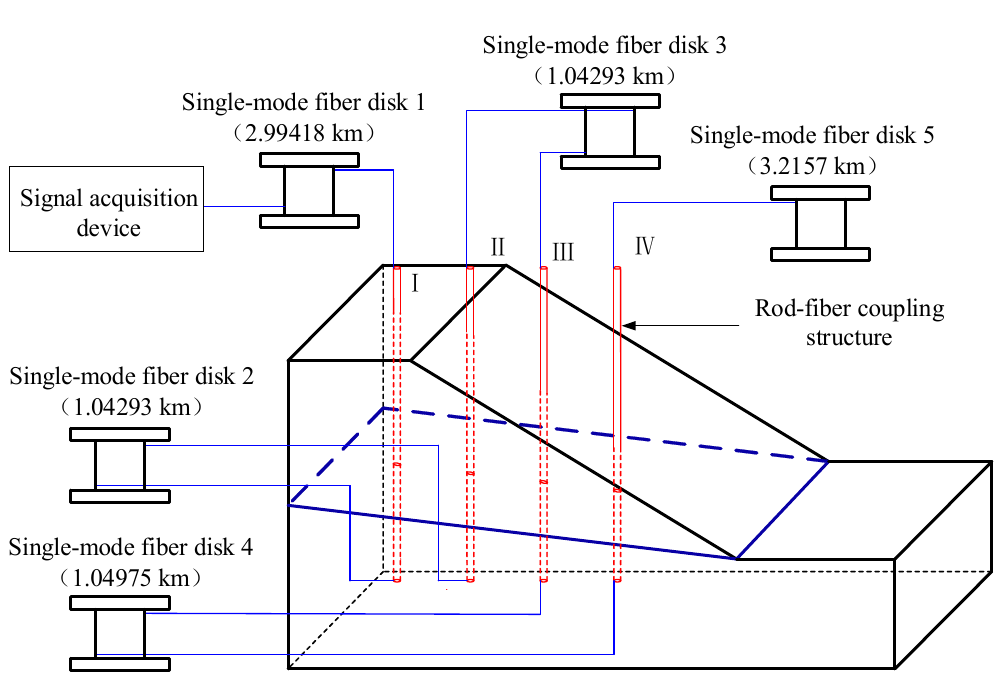
Figure 6. Installation of rod-fiber coupling structures.